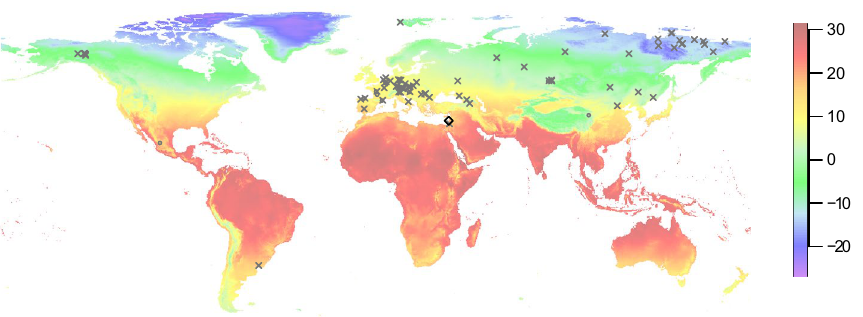
Figure 1. The location of Sefunim Cave compared to other sites where ancient DNA is preserved. The map is colored according to the mean annual temperature (°C), based on climatic data for the years 1970–2000. Sefunim Cave is indicated by the diamond. Other localities from which mammalian DNA from samples dated to at least 30 ka has been retrieved are noted (cross—skeletal remains; circle—sediments). See Supplementary Table S1 for a list of the localities plotted. The map was generated using the ‘maps’ package 87 in R version 3.5.2 (https:// www.r- proje ct.